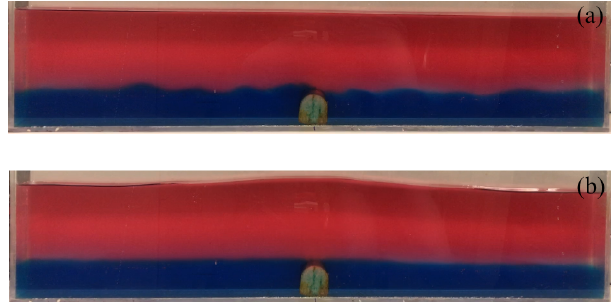
Figure 3. Snapshots from experiments with m = 1 (a) and m = 2 (b) surface seiche modes (configuration #3, cf. Table